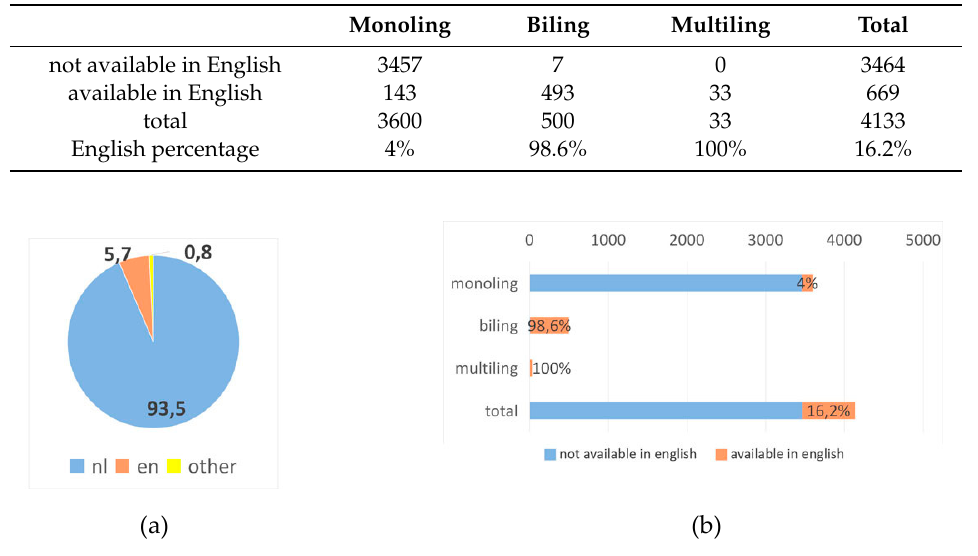
Figure A20. Visualization of the results for domain nl. ( a ) Primary languages pie chart and ( b ) English language availability bar chart.